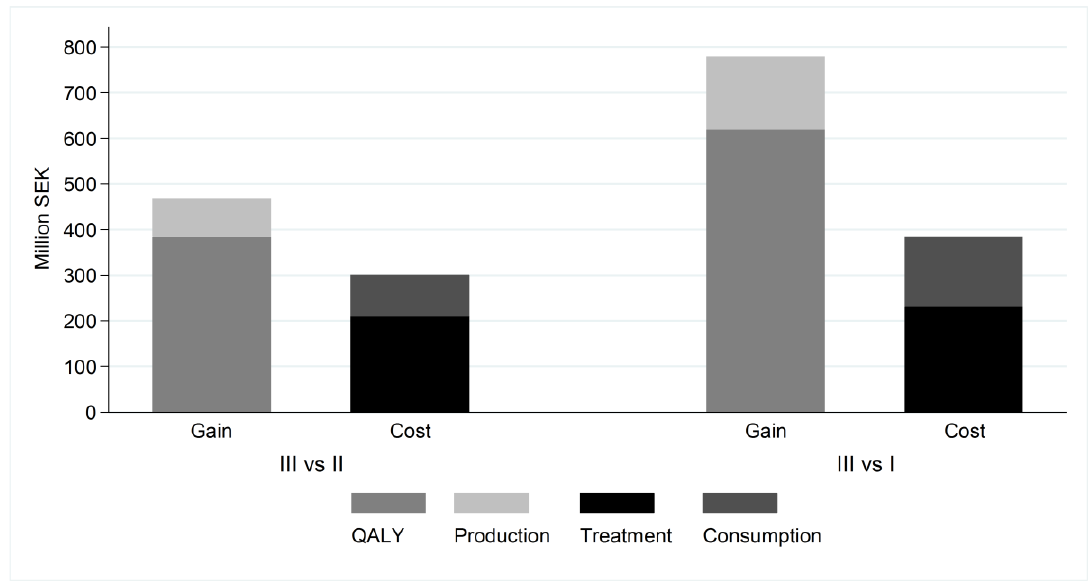
Figure 2: Increased gain and cost of the treatment of chronic myeloid leukaemia (CML). Era III, during which imatinib has been first-line treatment compared with previous technologies during Era II and Era I. Million SEK. Source Lundqvist et al.,